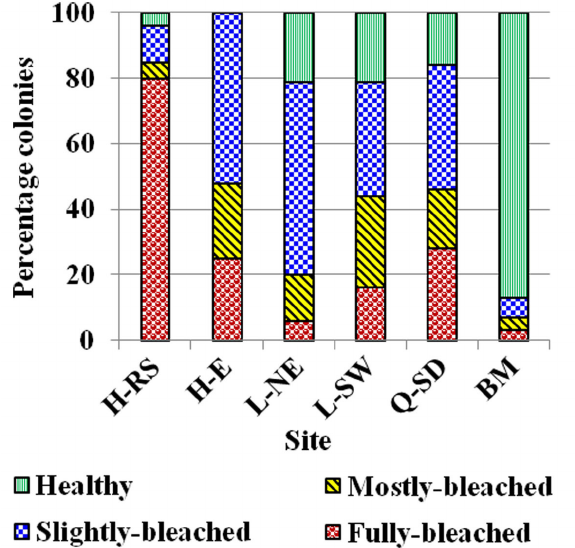
Fig. 3. – Percentage of fully bleached, mostly bleached, slightly bleached, and healthy corals at each site. Abbreviations: H-RS, southern site of Hormuz Island; H-E, eastern site of Hormuz Island; L-NE, northeastern site of Larak Island; L-SW, southwestern site of Larak Island; Q-SD, southern site of Qeshm Island; BM, Bu-Musa